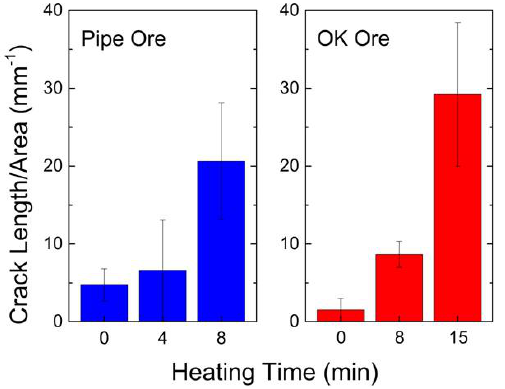
Figure 12. Crack length per unit area in untreated and microwave pretreated ores [48].